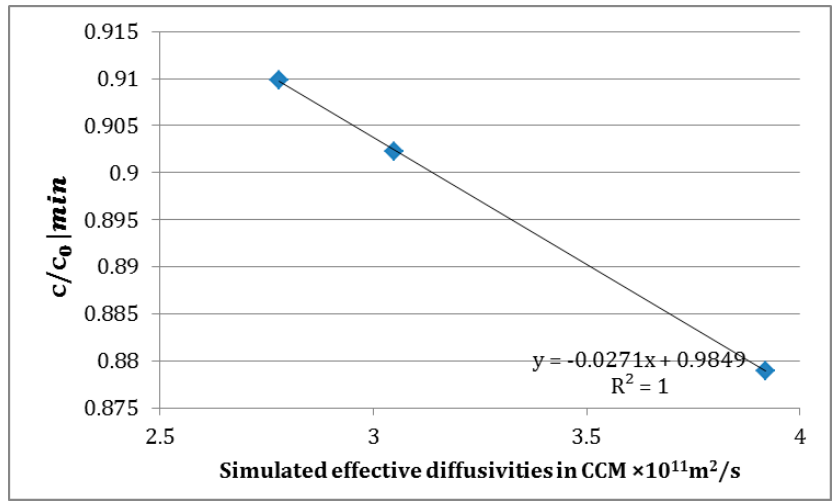
Figure 12. Relationship between simulated effective diffusivity and minimum concentration in HFMB.